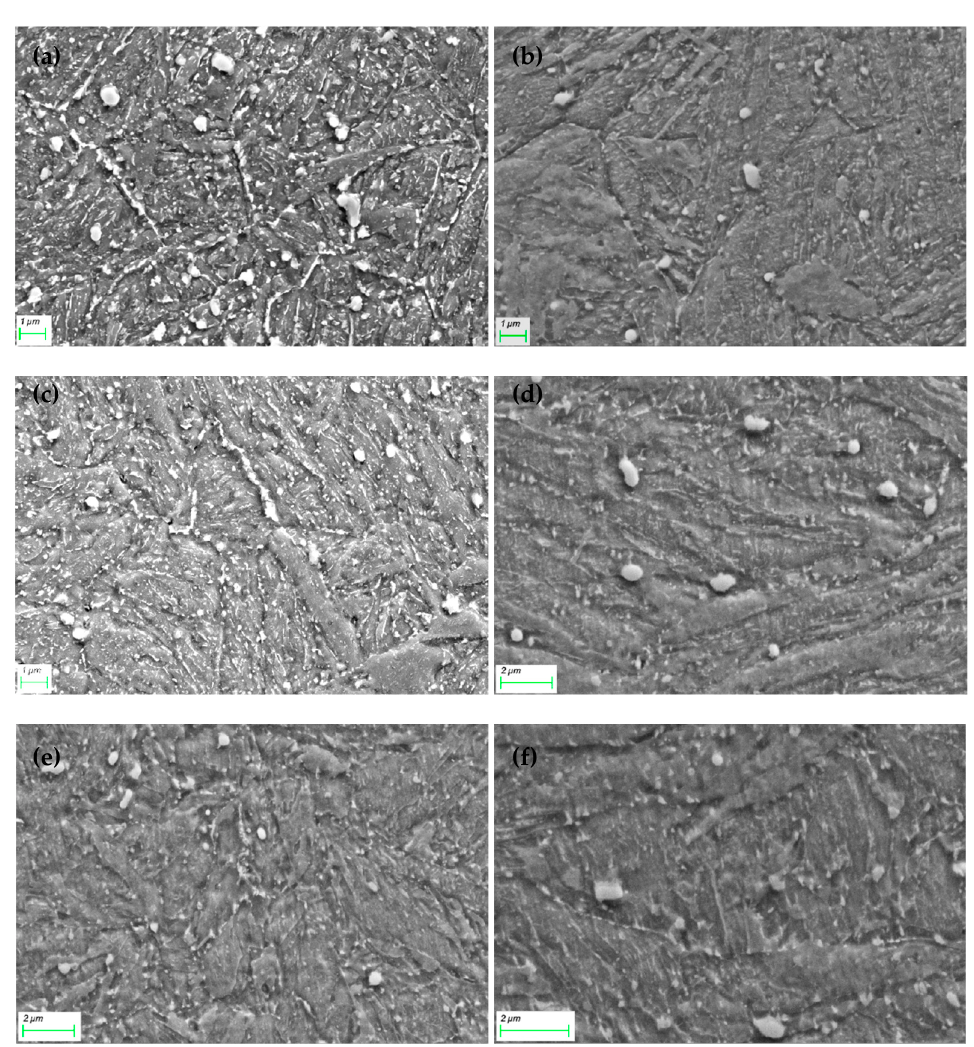
Figure 8. SEM morphology. ( a , b ) are quenching and tempering, ( c , d ) are after rolling, ( e , f ) are vacuum tempering.